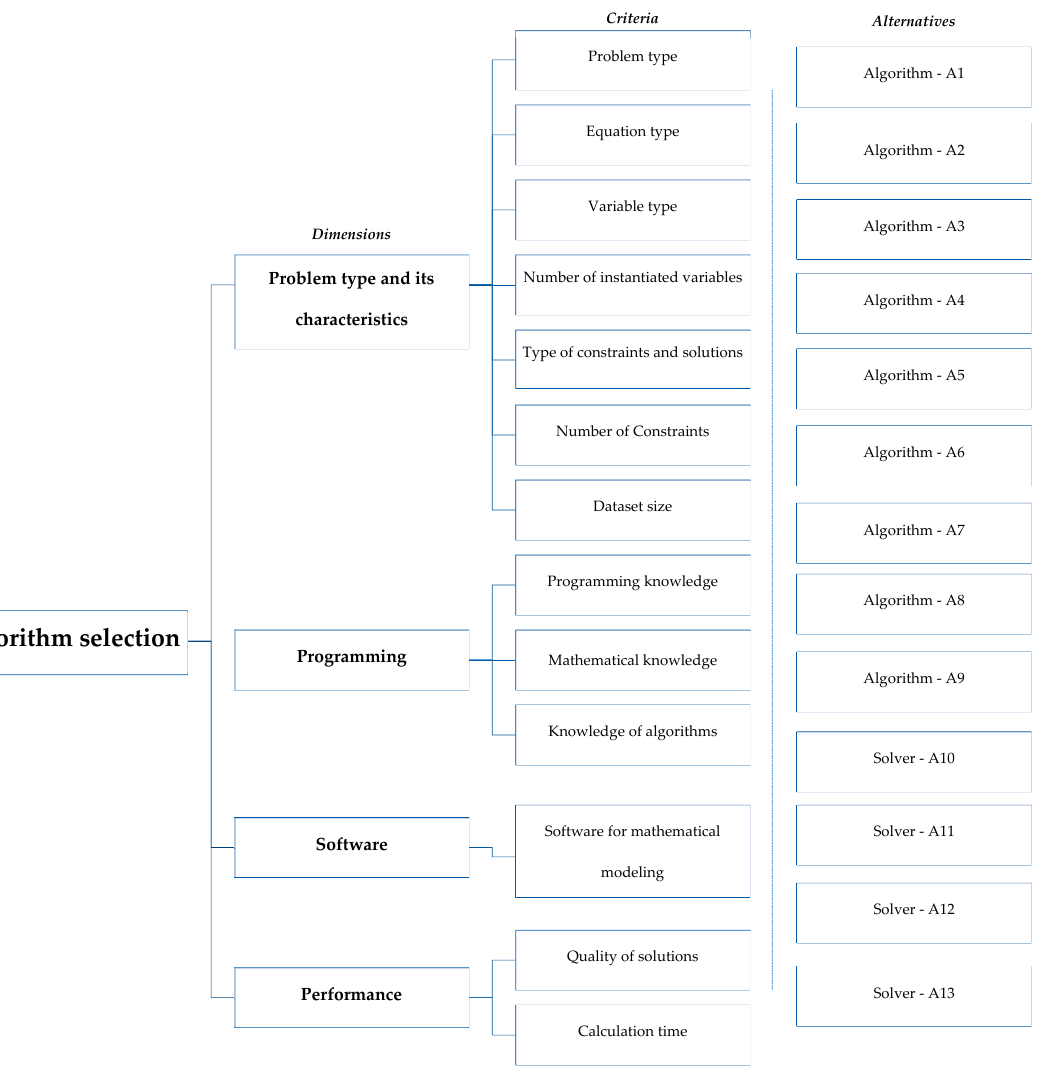
Figure 4. Hierarchical structure for algorithm selection.